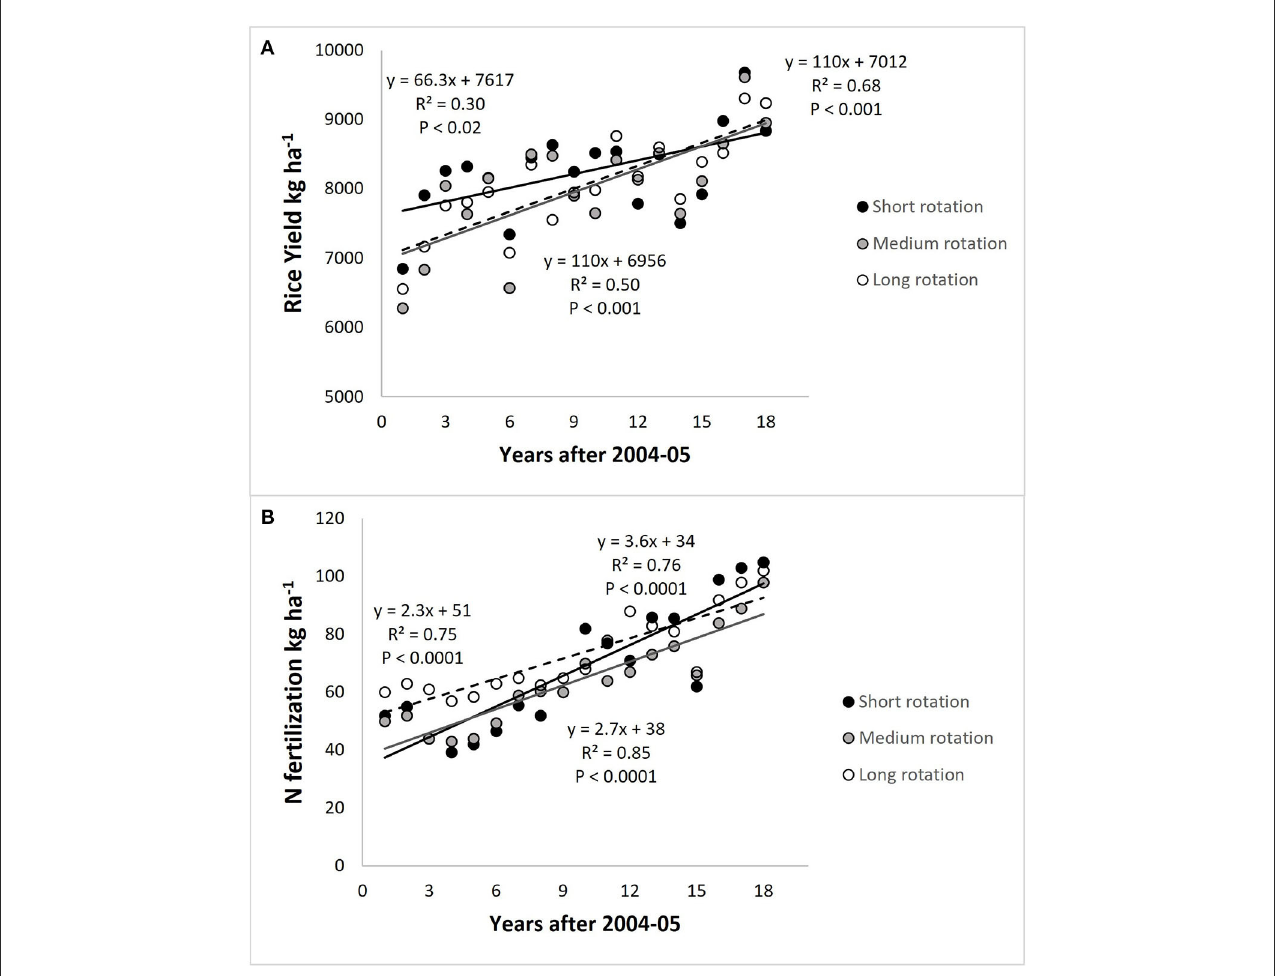
Figure 1). In the second phase, during 2018 only, the NUE exceeded the threshold due to less N fertilizer application. On average, the